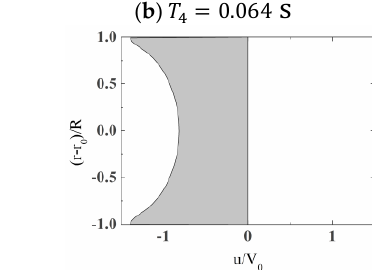
( c ) 𝑇 2 = 0.05 s Figure 11. Local pressure distribution at S1 monitoring position of different time ( 𝑇 0 = 0 s , 𝑇 1 = 0.044 s , and 𝑇 2 = 0.05 s ). Pressure (Pa) ( a ) 𝑇 0 = 0 s ( b ) 𝑇 1 = 0.044 s ( c ) 𝑇 2 = 0.05 s Figure 12. Pressure field evolution on the axis plane of the pipeline ( 𝑇 0 = 0 s , 𝑇 1 = 0.044 s , and 𝑇 2 = 0.05 s ). Stage 2: Figures 13 and 14 are respectively the axial velocity distribution and local pressure distribution at the S 1 monitoring position of different time, and Figure 15 is the pressure field evolution on the axis plane of the pipeline in this stage. When the pressure decrease wave generated at the upstream reservoir propagates to the downstream valve (Figure 15a, 𝑇 3 = 0.058 s = 𝑇𝑐 + 1.21 × 𝐿/𝑎 ), the pressure head at S 1 position decreases to 41.29 m, the velocity direction is from the valve to the reservoir (Figure 13a, 𝑈 ̅ = −0.102 m/s ), the reverse flow develops from the wall region and then diffuses to the core region, and the local pressure distribution in Figure 14a shows that the